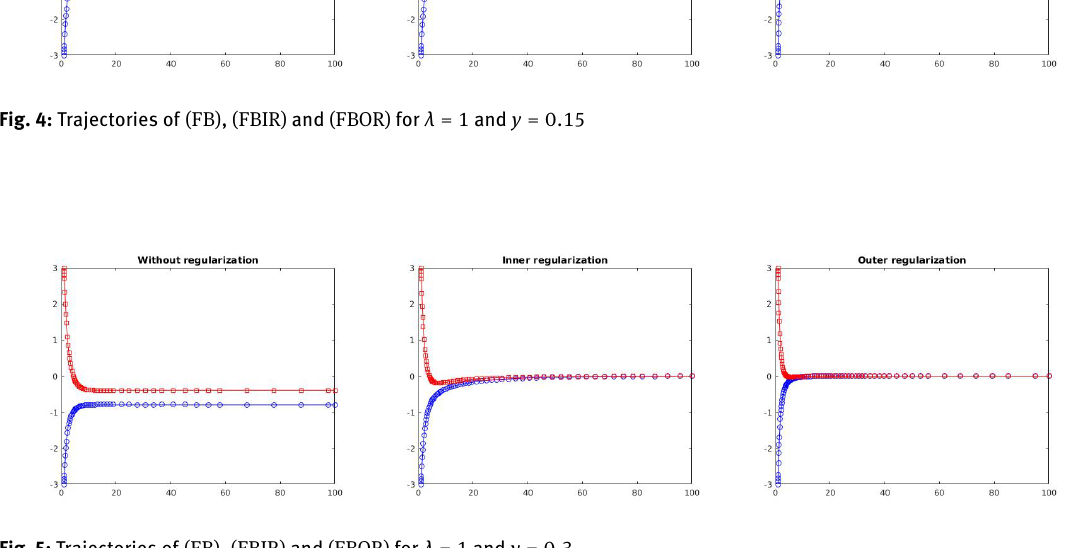
Fig. 5: Trajectories of (FB) , (FBIR) and (FBOR) for λ = 1 and γ =